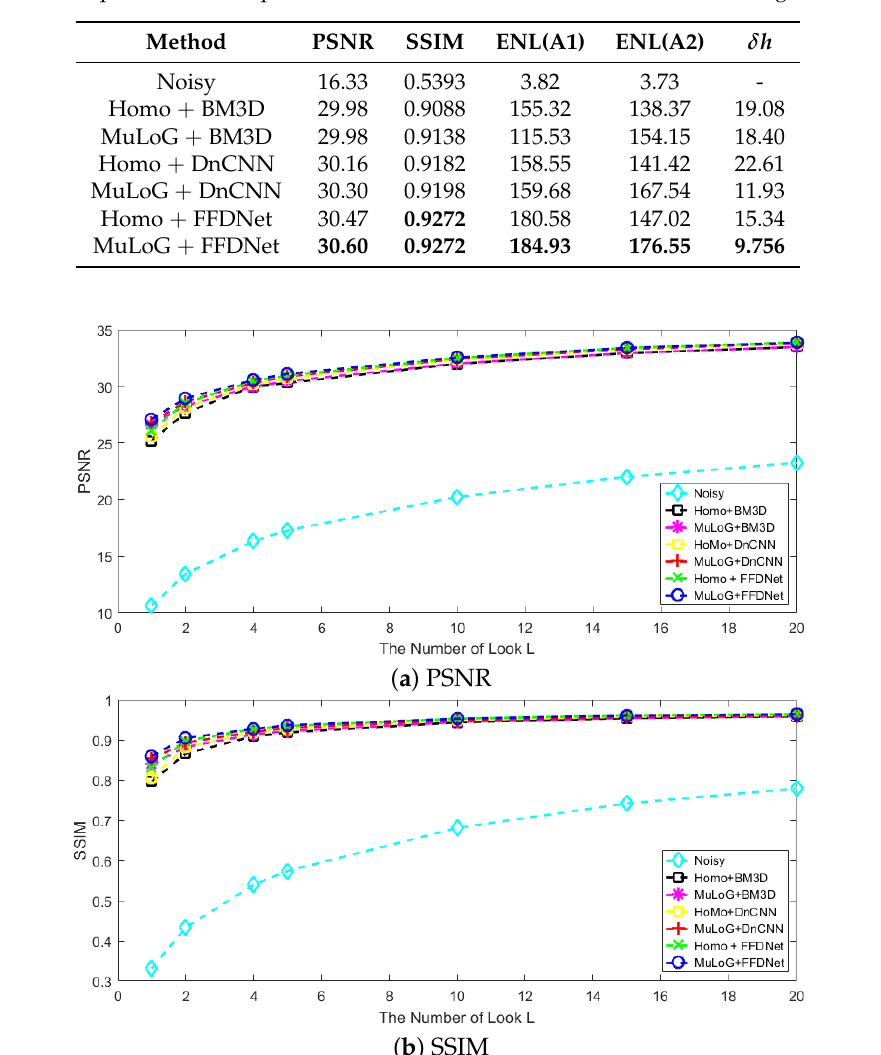
Figure 8. The performance for different methods on simulated SAR image in terms of PSNR and SSIM with different L : ( a , b ) PSNR and SSIM,